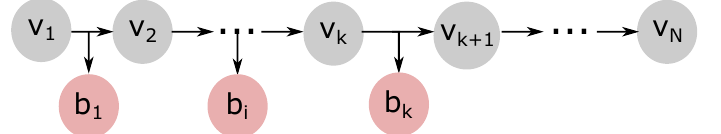
Figure 1. Generic representation of an early-exit